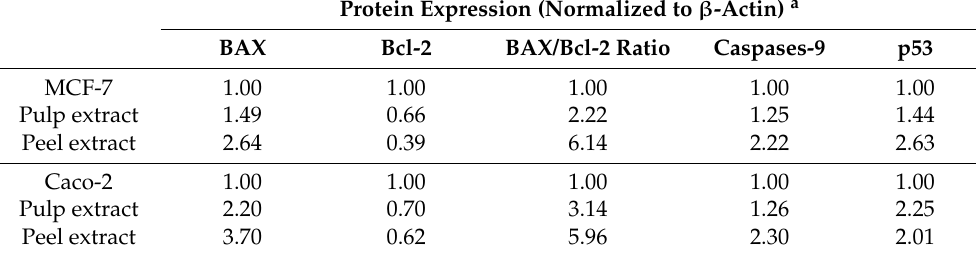
Table 6. Effect of pitaya peel and pulp extracts on BAX, Bcl-2, caspase-9, and p53 protein expression levels in MCF-7 and Caco-2 cells 48 h after treatment.